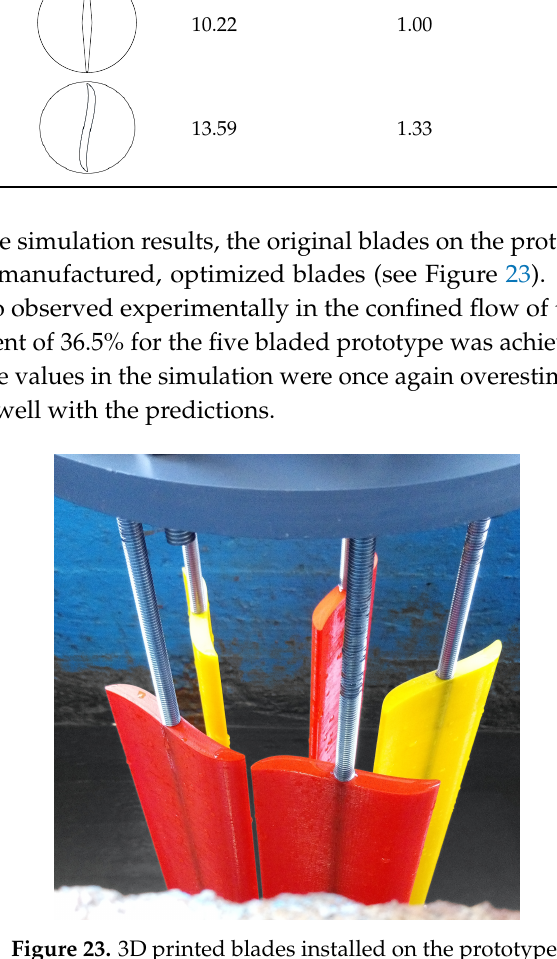
Figure 23. 3D printed blades installed on the prototype.